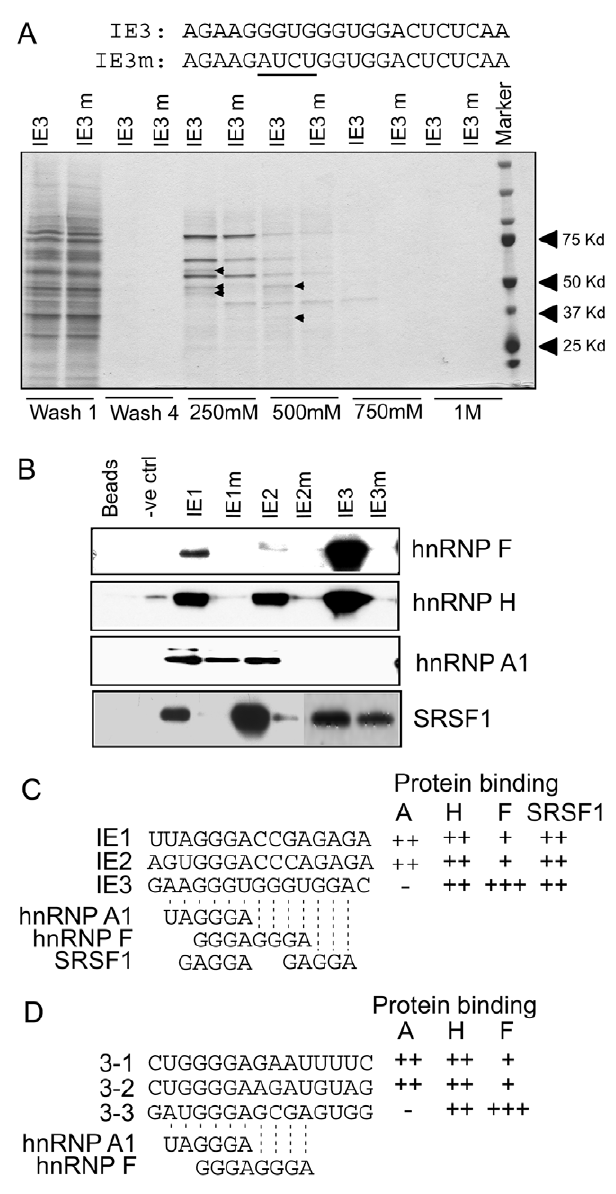
Figure 2. hnRNP A1 and -F/H and SRSF1 bind to G-rich motifs in intron 10. Panel A: RNA-affinity purification of HeLa nuclear proteins using templates IE3 or IE3m, which contains the GA7 mutation. Se- quences of IE3 and IE3m are given at top. Bound proteins were washed four times with 100 mM KCl and then eluted with increasing concen- trations of KCl. Proteins from washes 1 and 4 and from the KCl elution were separated on a 4–12% Bis-Tris gel and stained with Coomassie blue. Arrowheads indicate differential protein bands between the two RNA templates. Panel B: In vitro RNA pull-down assay using RNA templates IE1, IE2 and IE3 and their cognate mutants. Bound proteins were separated by gel electrophoresis and immunoblotted for hnRNP A1, hnRNP H, hnRNP F or SRSF1. Panel C: Summary of binding to 5 9 GA-rich